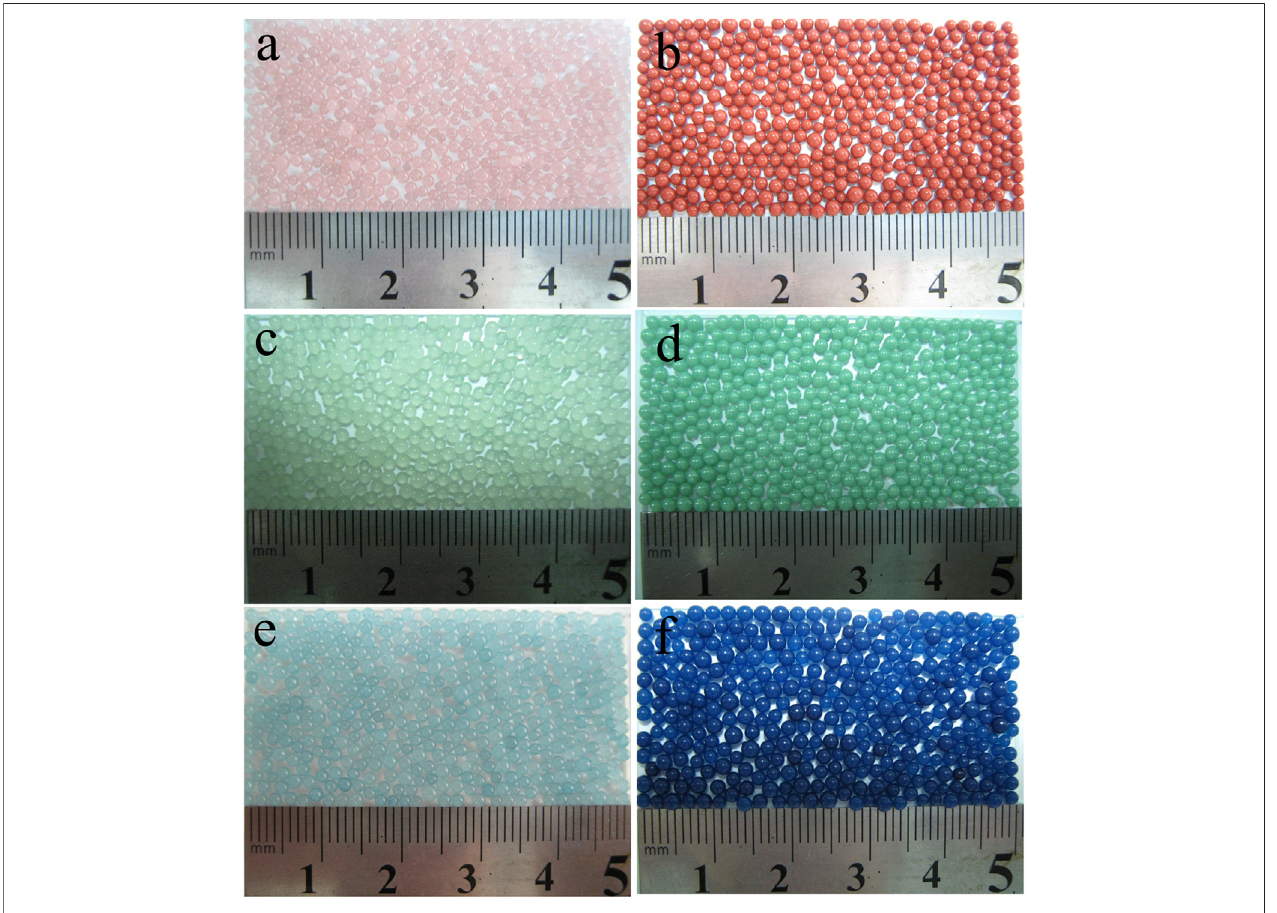
FIGURE 13 | Colorized PS composite beads with different modi fi ed pigments: (A,B) iron oxide red, (C,D) dark green, and (E,F) China blue.